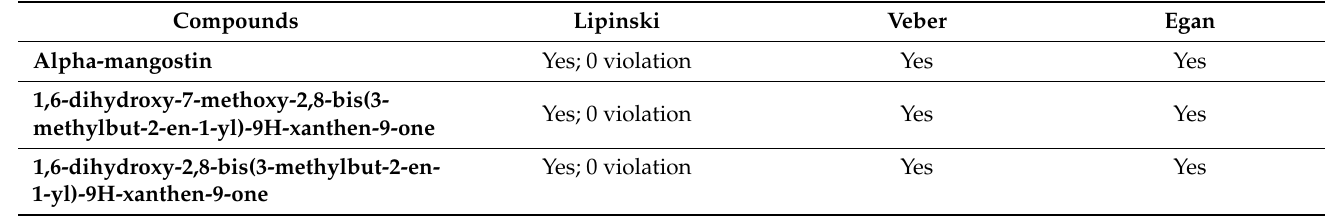
Table 5. Drug likeness of Alpha-mangostin and modified compounds of Alpha-mangostin. Compounds Lipinski Veber